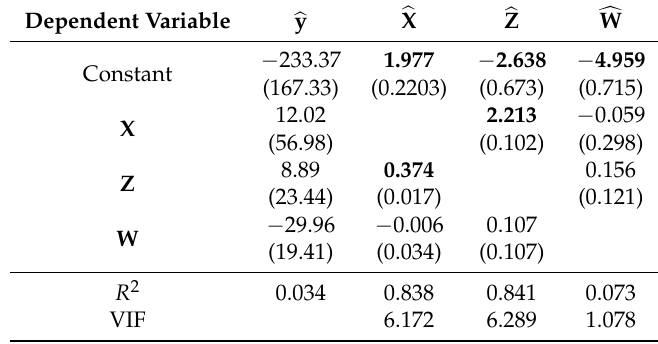
Table 9. Estimation by OLS of the second simulated model and its corresponding auxiliary regressions (estimated standard deviation in parenthesis and coefficients significantly different from zero in